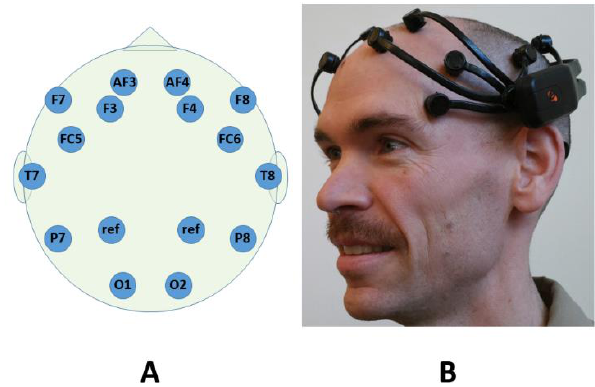
Figure 1. Scalp electrode locations ( A ) covered by the Emotiv Epoc system; and the Emotiv Epoc system as it would be worn by a subject ( B ). The electrode labeling convention follows the Modified Combinatorial 10–20 Standard [24].